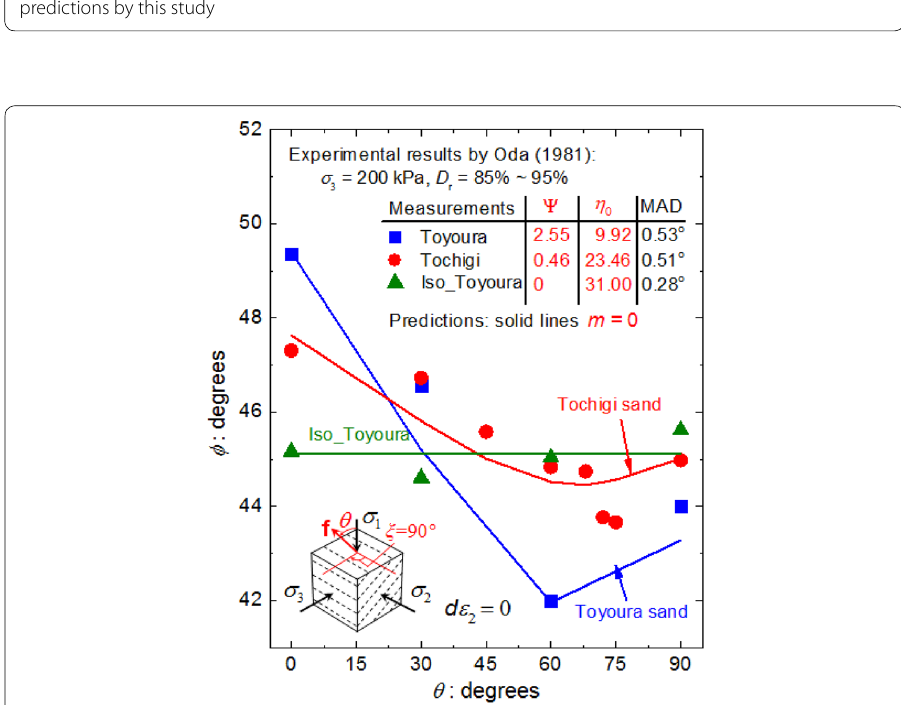
Fig. 18 Comparison between plane strain compression test results of cross-anisotropic Toyoura sand, cross-anisotropic Tochigi, and isotropic Toyoura sand by Oda et al. [7] and predictions by this